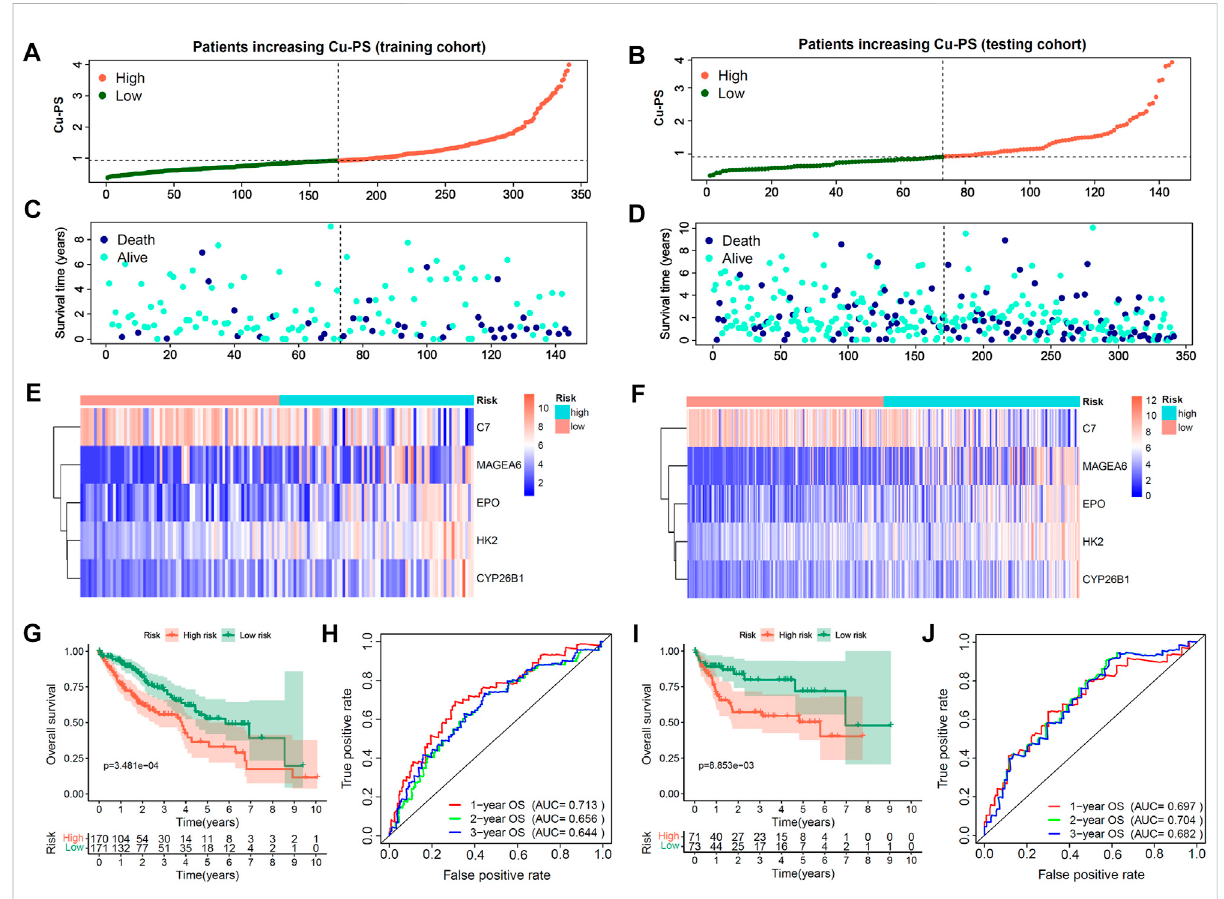
FIGURE 4 Construction and validation of Cu-PS in training and testing cohorts. (A,B) The range of Cu-PS in the training and testing cohorts, and patients were cutoff into high- and low-two subgroups by the and median value of Cu-PS. (C,D) The distribution plots showed the survival status of patients with increasing Cu-PS in the training and testing cohorts. (E,F) The heatmaps showed the expression of 5 hub Cu-DEGs between two Cu-PS subgroups in the training and testing cohorts. (G,H) The Kaplan-Meier curves of overall survival (OS) between the two subgroups in the training and testing cohorts. (I,J) The ROC curves of the Cu-PS in predicting 1-, 2-, and 3-year OS in the training and testing